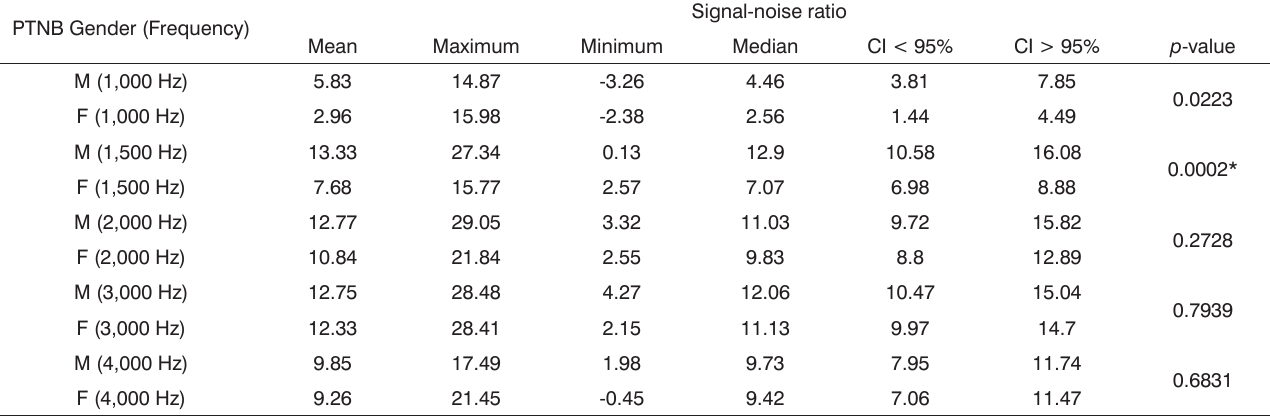
Table 5. Description of the signal-noise ratio variable of TEOAEs (in dB SPL), for preterm newborns according to gender in the 1,000 to 4,000Hz frequency bands.